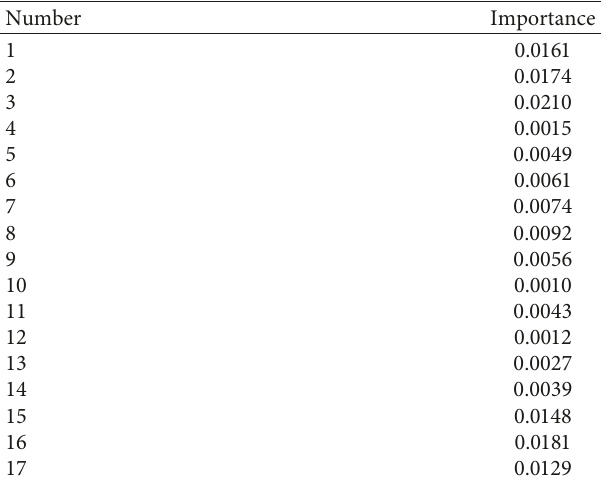
Table 17: Importance of components in Example